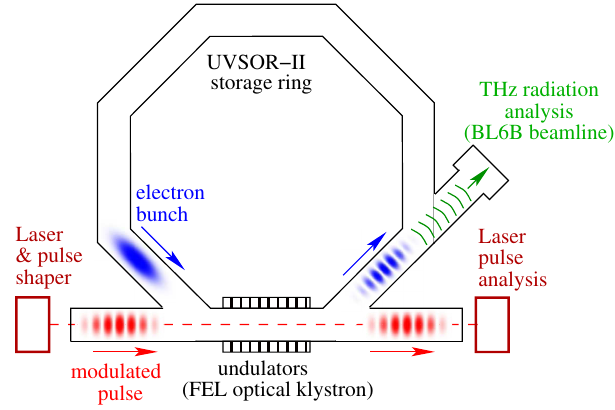
FIG. 1. (Color) Global view of the experiment at the UVSOR-II storage ring. Laser pulses with a sinusoidal modulation interact inside an undulator (FEL beam line), and the THz radiation analysis is performed at the terahertz BL6B beam line.